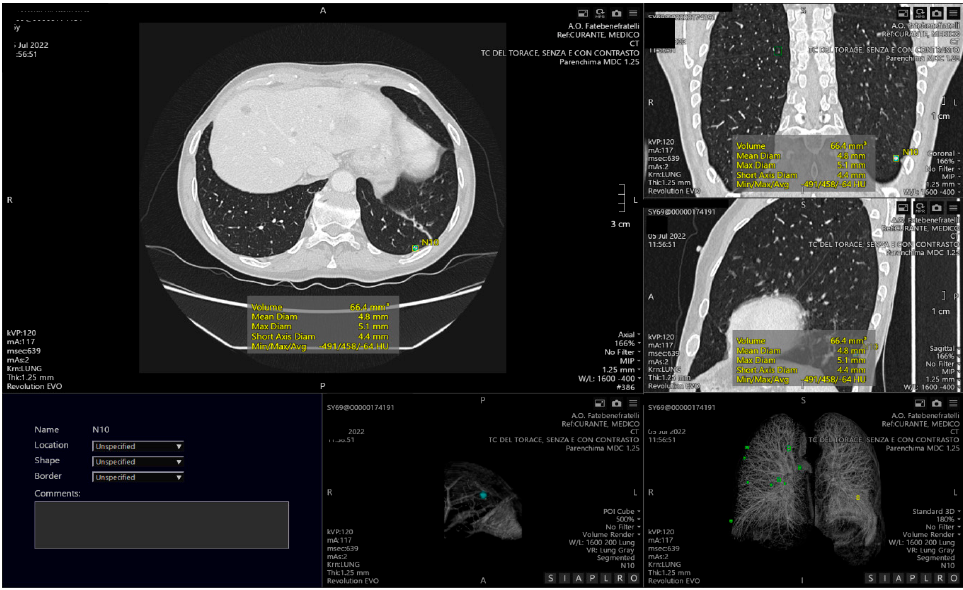
Figure 1. Example of computed aided detection with automatic identification of pulmonary nodules, both visible on axial CT images and in the volumetric reconstruction.